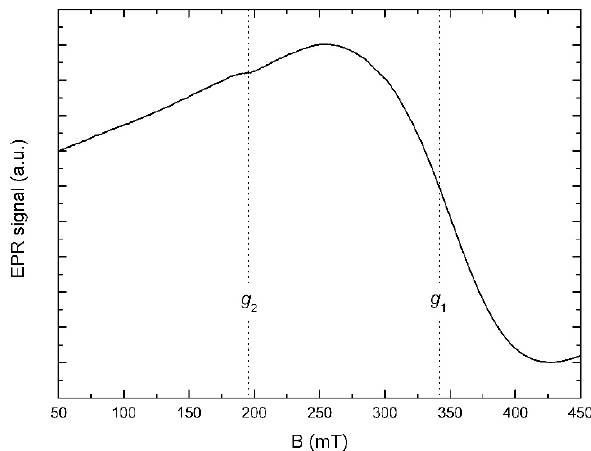
Figure 3. EPR spectrum of 3 (powder) recorded at room temperature.